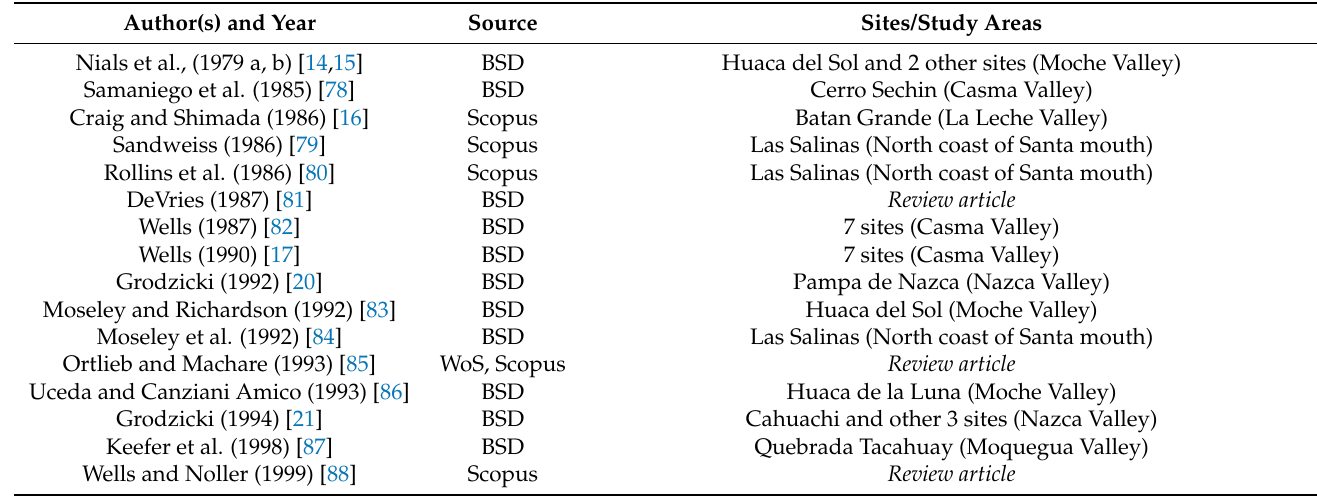
Table 3. Summary of reviewed documents. BSD = Bibliography of selected